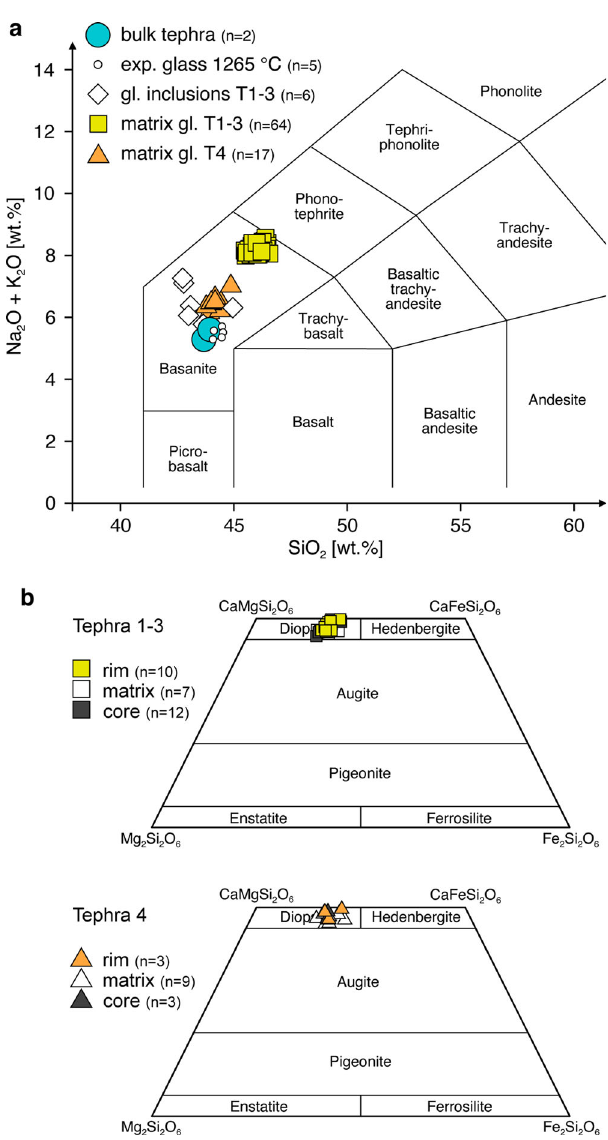
Fig. 4 Geochemistry of 2021 Cumbre Vieja eruption products. a Total alkali-oxides versus silica plot for a variety of natural and experimental materials. The bulk compositional information for bulk ash samples (large blue dots) along with other products indicate basanitic bulk rock composition. Glass inclusions, and some matrix glasses do not deviate signi fi cantly from the bulk rock. Glass analyses of 1-atm crystallization experiments (small open circles), which derive from the bulk ash, plot on the bulk rock and have equivalent provenance to the rheometry glasses, indicating very little compositional shift during viscosity measurements. Matrix glass in pyroclasts from tephra sample T1-3 demonstrates natural variability due to groundmass crystallization. b Pyroxene quadrilateral compositions of clinopyroxene microphenocrysts ( fi lled symbols) and groundmass microlites (open symbols) in tephra collected in El Paso (Tephra 1 – 3) and Santa Cruz (Tephra 4). These data form the basis for geothermobarometry calculations, which yield approximate magma temperature and pressures according to refs. 32 and 33